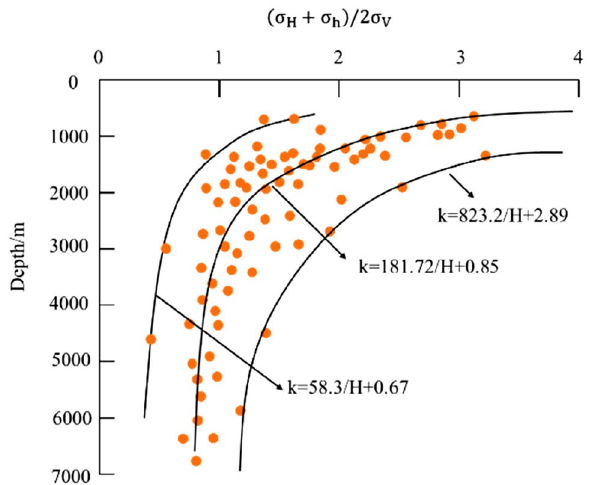
Fig. 10 The ratio of the horizontal average in situ stress to the verti- cal stress in Northeast Sichuan